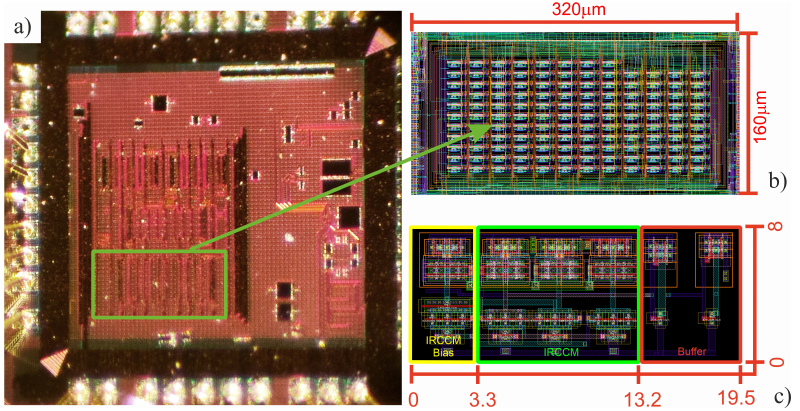
Figure 2. Test-chip picture ( a ), layout of the array of 128 PUF bitcells ( b ) and the single IRCCM PUF cell ( c ).